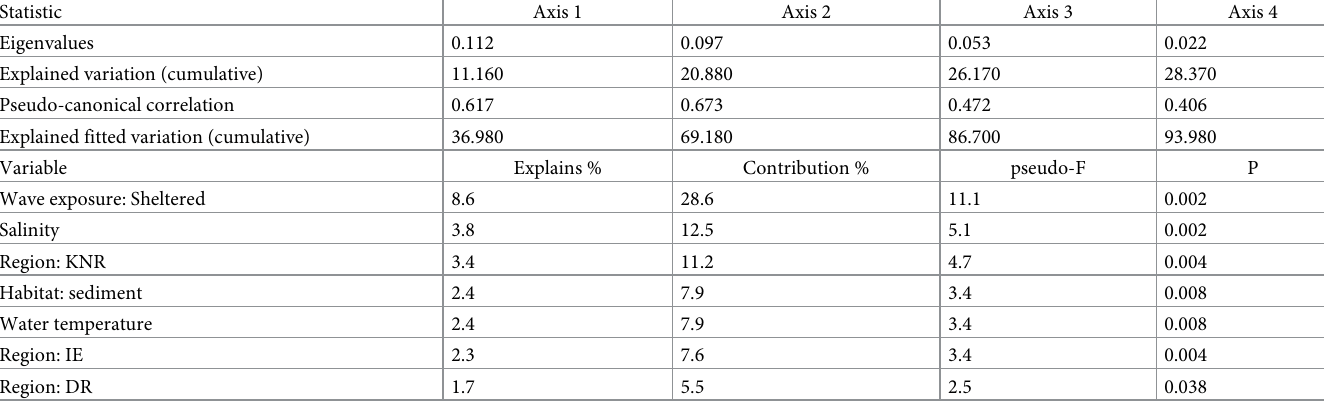
Table 4. (a) Results of redundancy analysis (RDA) on ln(x+1) transformed benthic feeding guild abundance (num. m -2 ) by transect. (b) Conditional effects of Monte- Carlo permutation results on the